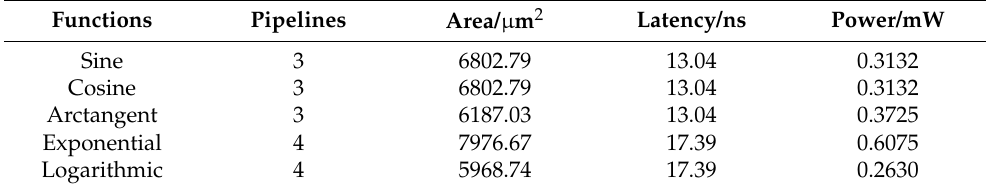
Table 5. Performance, power and area of a hardware circuit which supports a single transcenden- tal